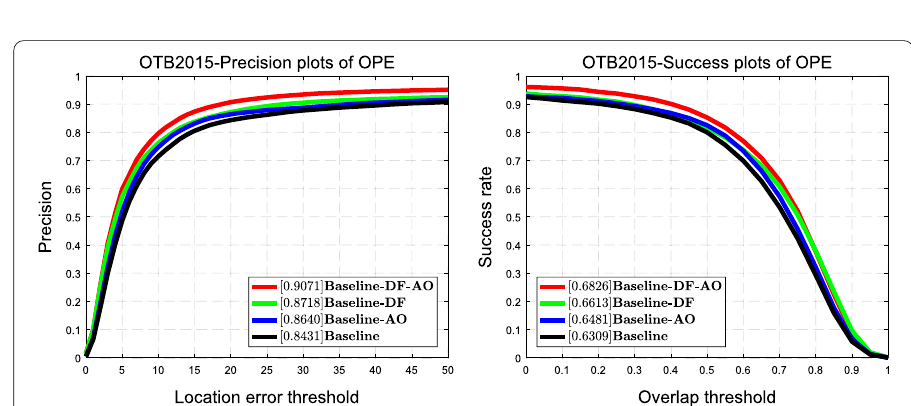
Fig. 12 Performance evaluation results of compared itself with different modules enabled on OTB2015